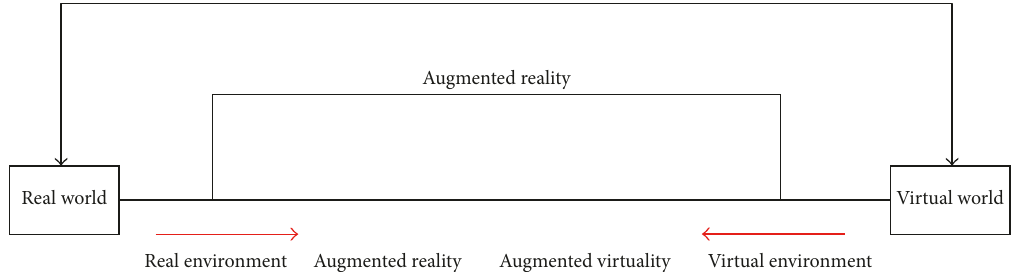
Figure 1: Milgram’s reality-virtuality continuum extended.